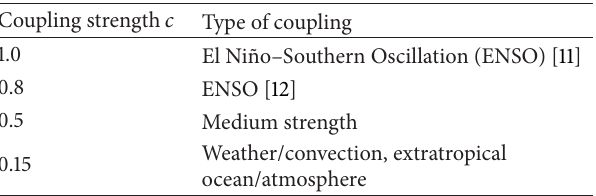
Table 1: Values of the coupling strength parameter 𝑐 used in the numerical experiments [11,